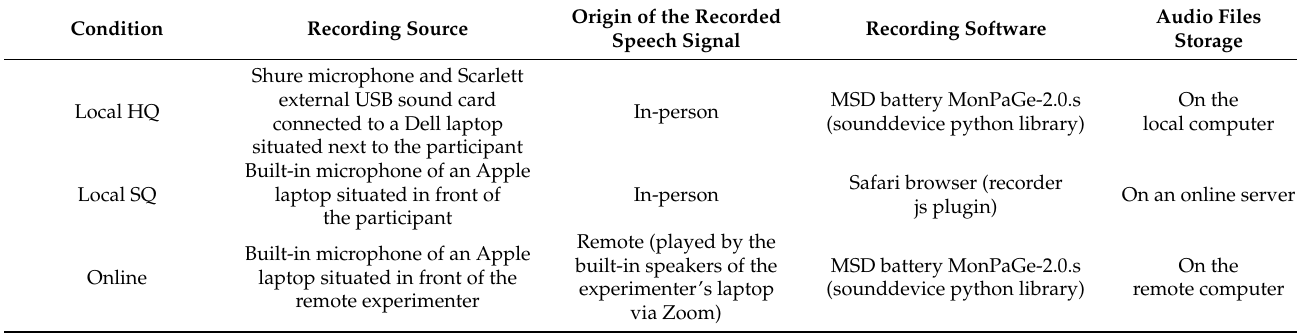
Table 2. Key differences between the three recording